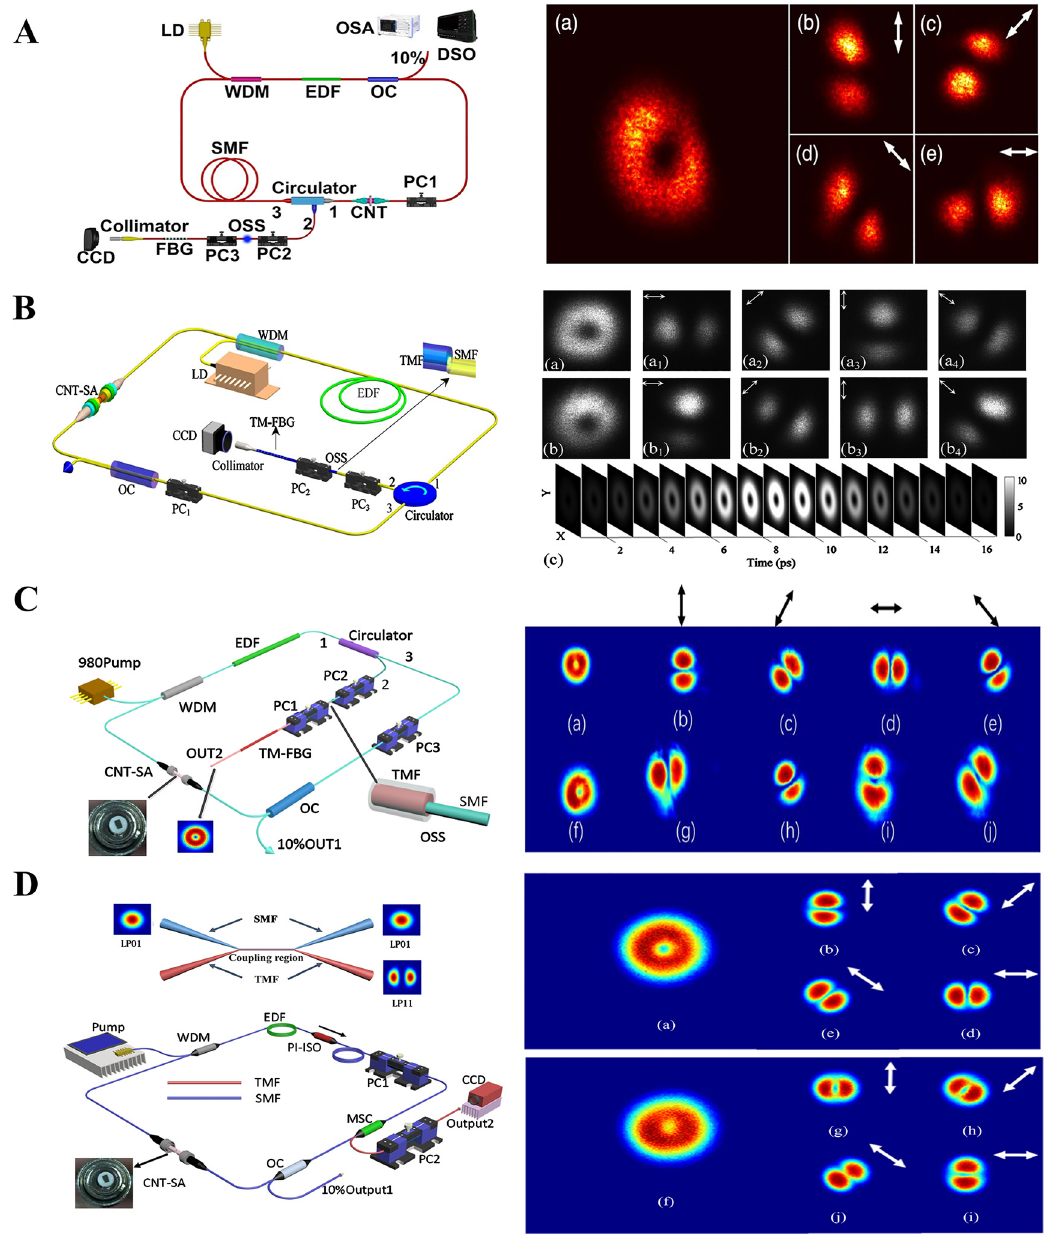
Figure 7: Typical experimental setup and intensity distributions of the mode-locked fiber laser with CVB generation based on CNT SAs. (A – C) The mode-locked CVB all-fiber lasers with an OSS and a few-mode FBG. Zhou et al. [239]. © Chinese Laser Press 2016; Mao et al. [240]. © AIP Publishing 2017; Cai et al. [241]. © MDPI 2018. (D) The mode-locked CVB all- fi ber laser with a home-made mode selective coupler composed of SMF and FMF. Zhang et al. [243]. © IEEE 2018. CNT SA, carbon nanotube saturable absorber; CVB, cylindrical vector beam; OSS, offset splicing spot; FBG, fi ber Gragg grating; SMF, single mode fi ber; FMF, few-mode fi obtain both radially and azimuthally polarized beams, the wavelength of fi ber lasers with CVB emission [242]. In 2018, CVB laser also can operate and switch at 1532.5 and a switchable dual-wavelength femtosecond CVB fi ber laser 1555.5 nm through tuning the intracavity polarization based on CNT for mode locking and MSC shown in controller due to the birefringence fi ltering effect introduce Figure 7D for broadband mode conversion was demon- by the MSC. strated by Zhang et al. [243]. In addition to being able to